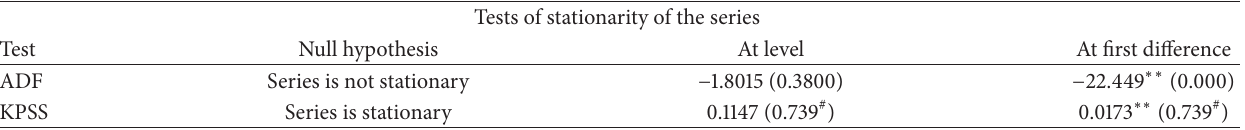
Table 2: Result of Unit Root test of preintervention period.